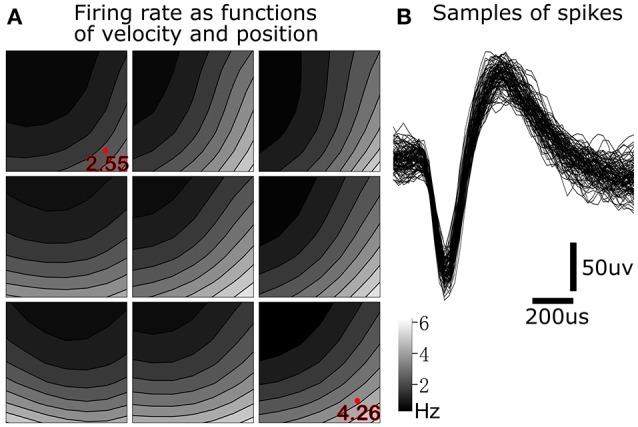
Position-velocity interaction in the encoding of a motor cortical single unit. (A) Illustration of position-velocity interaction tuning. Shading indicates firing rate. Each sub-panel depicts velocity tuning when the cursor was in a portion of the position work space, with the sub-panel's position corresponding to the cursor position. Location within each sub-panel corresponds to the 2D cursor velocity, with zero velocity in the center. See text for details. (B) Example spike waveforms from this single unit.